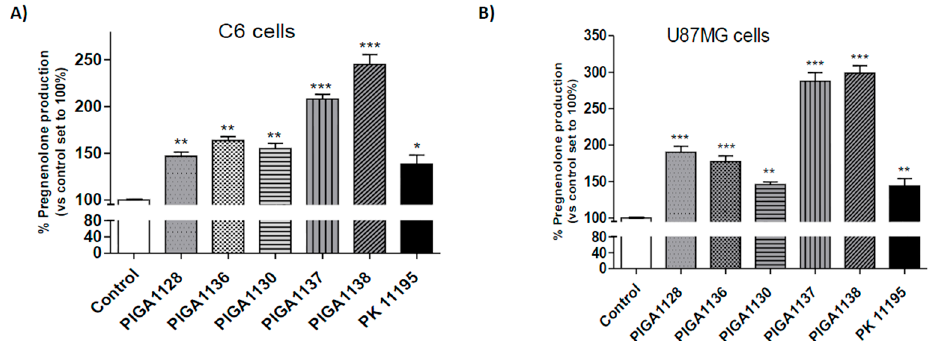
Figure 2. Effects of the PIGA ligands on pregnenolone production. C6 glioma cells ( A ) and U87MG